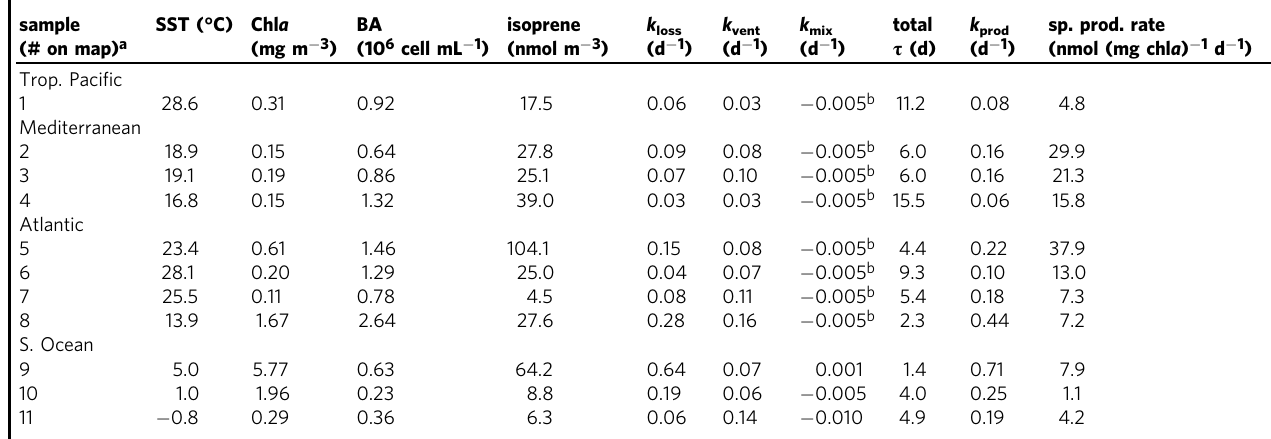
Table 1 Measured biological variables and isoprene process rate constants. sample (# on map) a